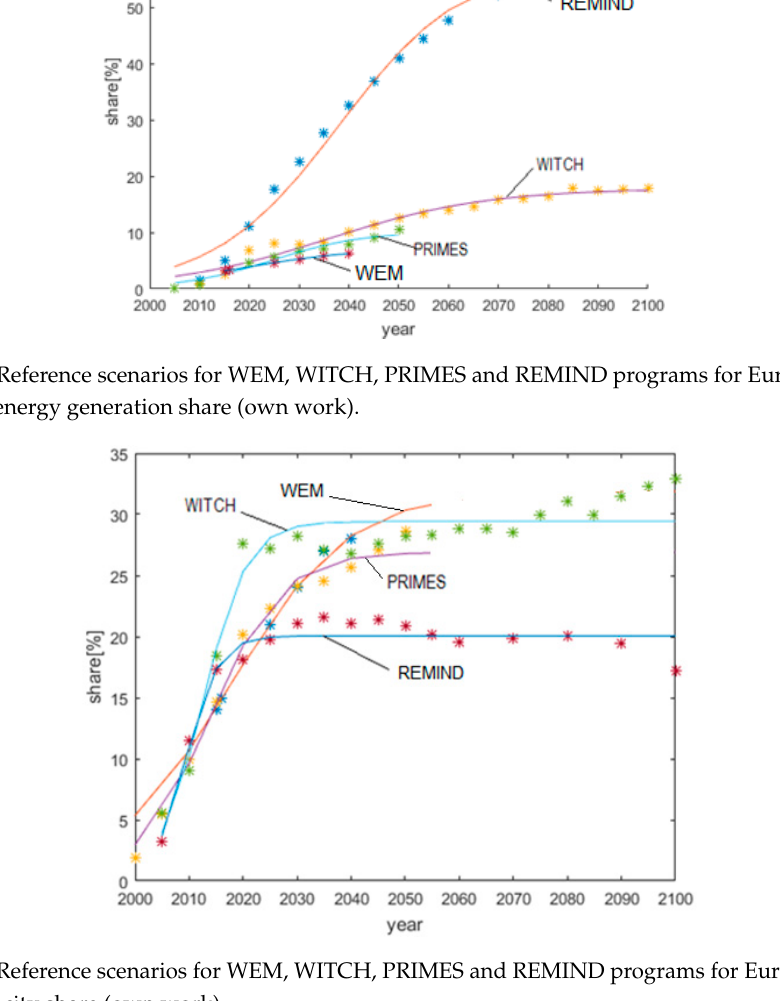
Figure 12. Reference scenarios for WEM, WITCH, PRIMES and REMIND programs for Europe’s solar PV power energy generation share (own work).